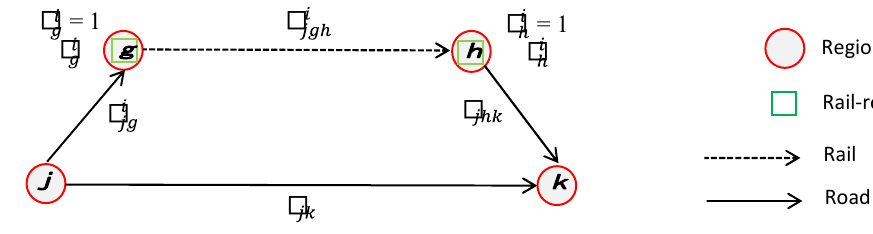
Figure 4. Location and flow decision variables.